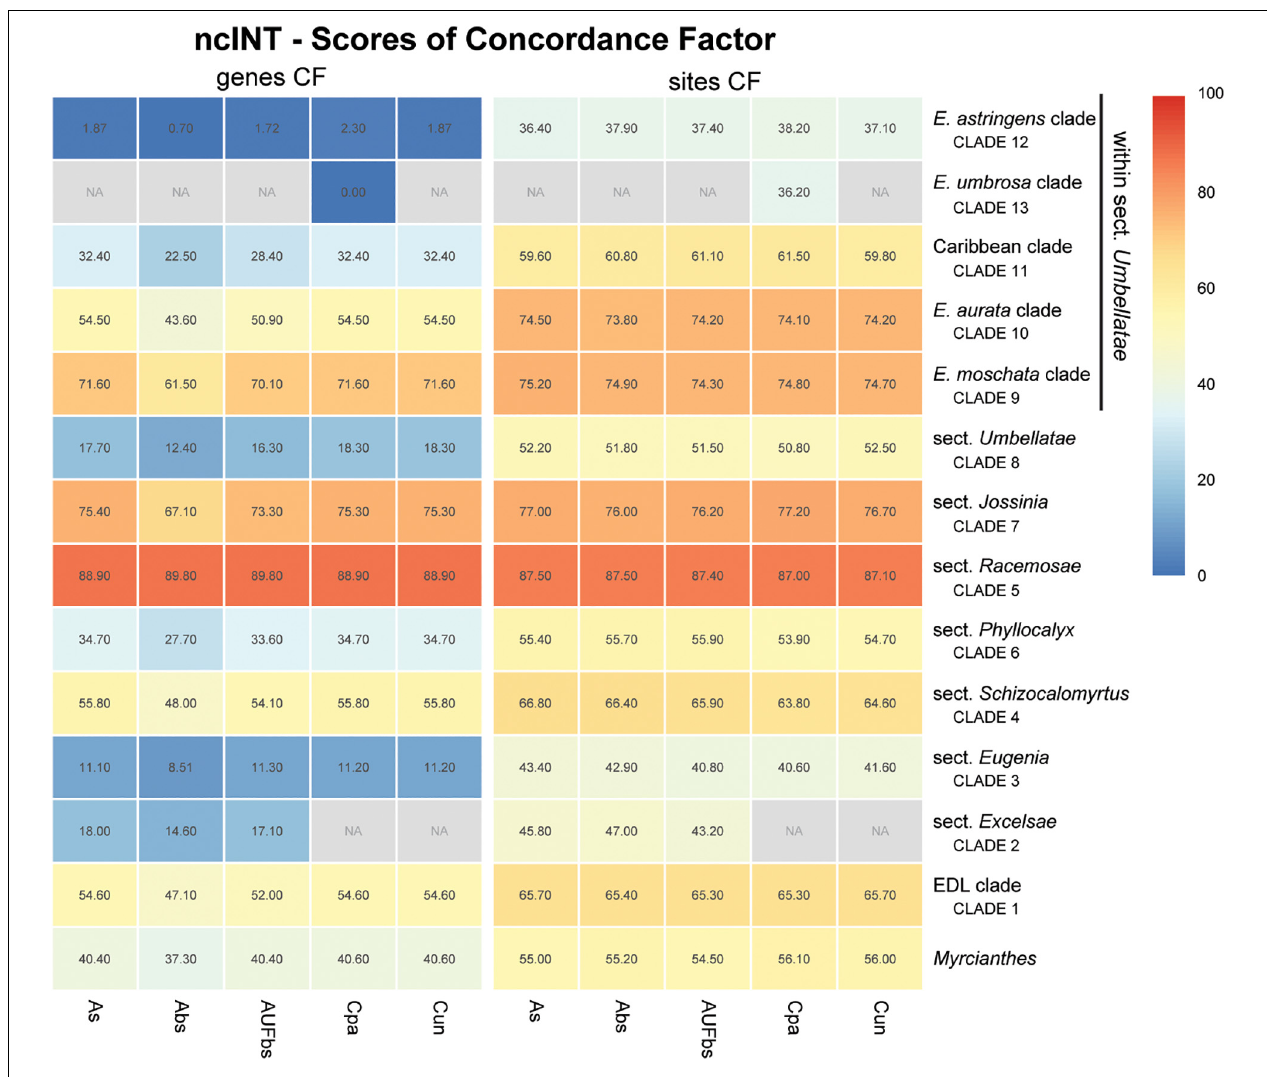
FIGURE 7 | Heatmap of gene and site concordance factors (gCF and sCF) recovered in focus clades of the nuclear intronic non-coding loci (ncINT) in Eugenia . Each column is a method of phylogenetic reconstruction, and each row corresponds to a clade in Figures 2–4 . Shading indicates percentage of concordance factor values recovered (Cpa, concatenated and partitioned ML reconstruction; Cun, concatenated and unpartitioned ML reconstruction; As, coalescent Astral tree with local posterior probability support; Abs, coalescent-based Astral tree with 100 bootstrap replicates; AUFbs, coalescent Astral tree with 1,000 ultrafast bootstrap replicates; NA, node not